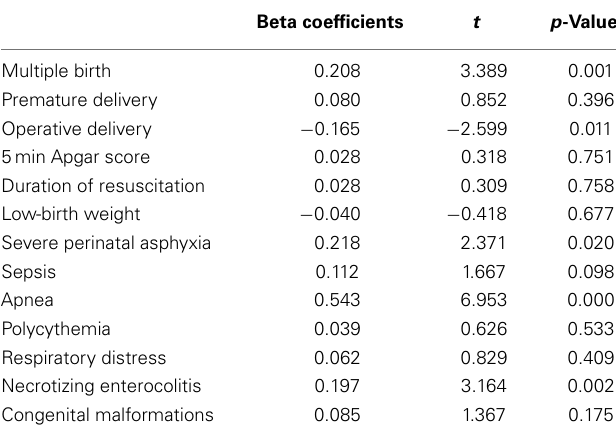
Table 8 | Neonatal risk factors of perinatal deaths .